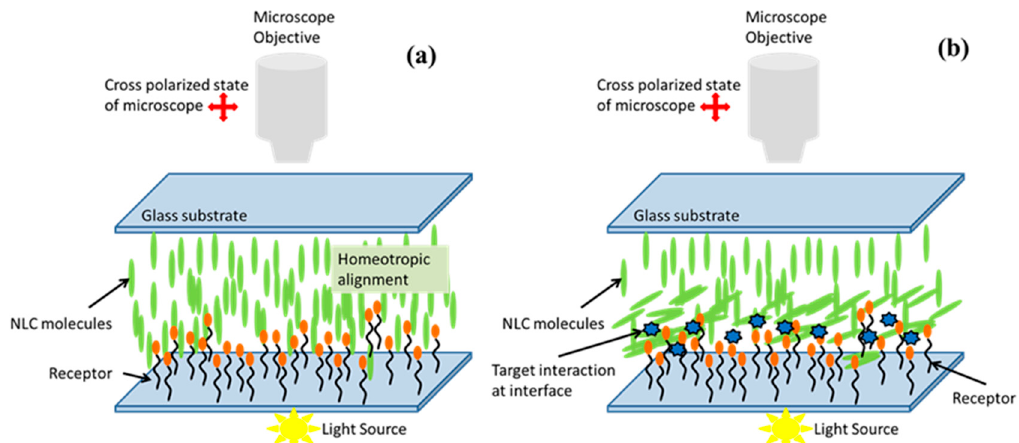
Figure 8. Schematic diagram of one of the concepts used in the biosensing by NLCs. ( a ) Only the receptor on the substrate is able to induce the homeotropic alignment of NLCs, ( b ) The NPs are introduced along with the receptor with required specification that disrupts the molecular alignment of the NLCs and change in transmission is observed under polarizing microscope.